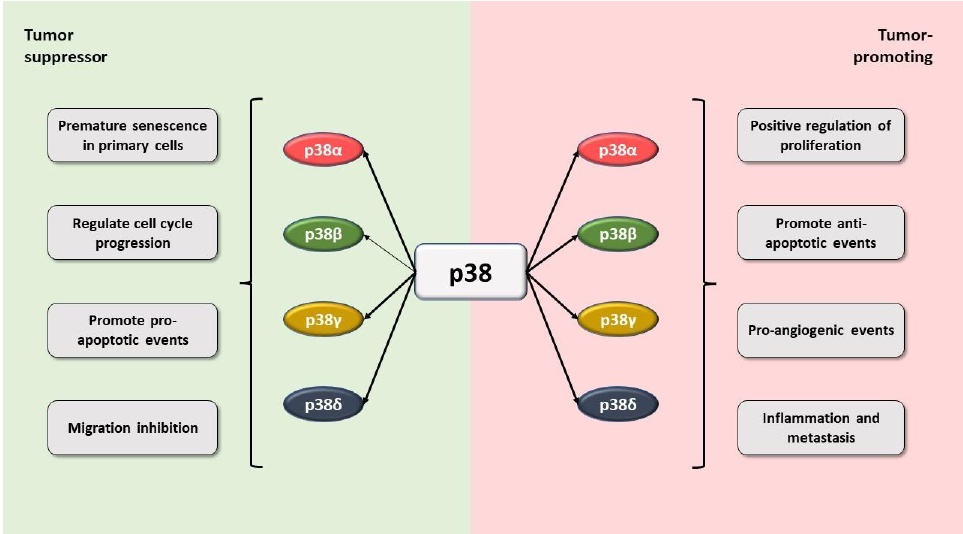
Figure 4. The p38 MAPK signaling pathway plays a dual role in cancer development. The p38 isoforms are able to promote both pro-oncogenic and tumor suppressive processes. Figure created using Servier Medical Art by Servier, which is licensed under a Creative Commons Attribution 3.0. Unported License: https://smart.servier.com (accessed on 23 November